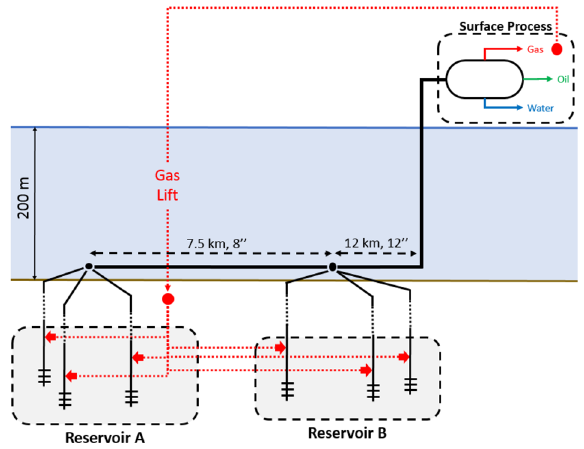
Fig. 1 Production system used in this